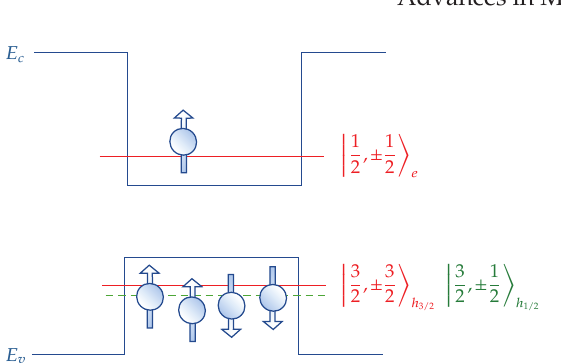
Figure 2: Two-level approximation of QD for the quantum network